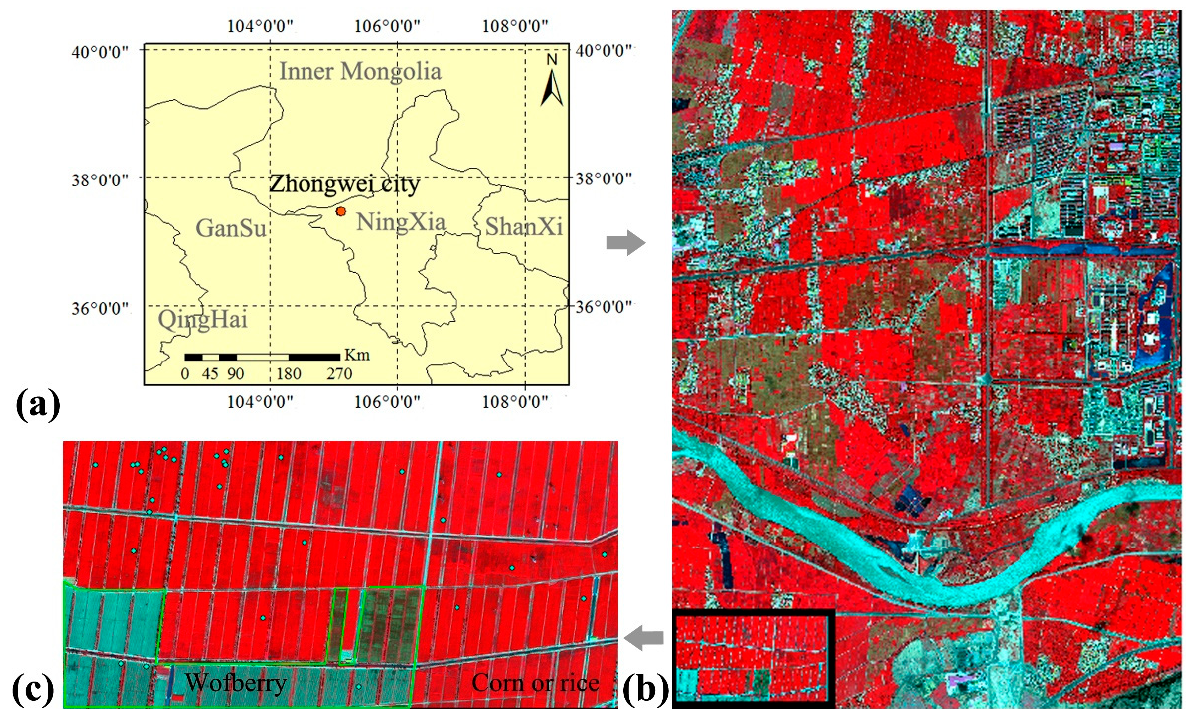
Figure 2. Map and false-color images of the study area. ( a ) Map of the study area, ( b ) World-View 3 image in Zhongwei city, and ( c ) World-View 3 image of farmland in Zhongwei city. The green points in ( c ) are the measuring sample, the blue area in ( c ) is the planting area of wofberry, and the red area in ( c ) is the mixed planting area of rice and corn.